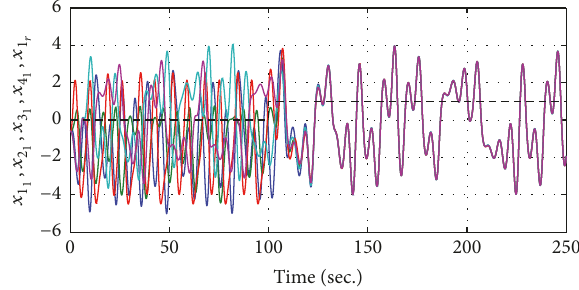
Figure 4: Outputs of each node and reference system before and after applying coupling